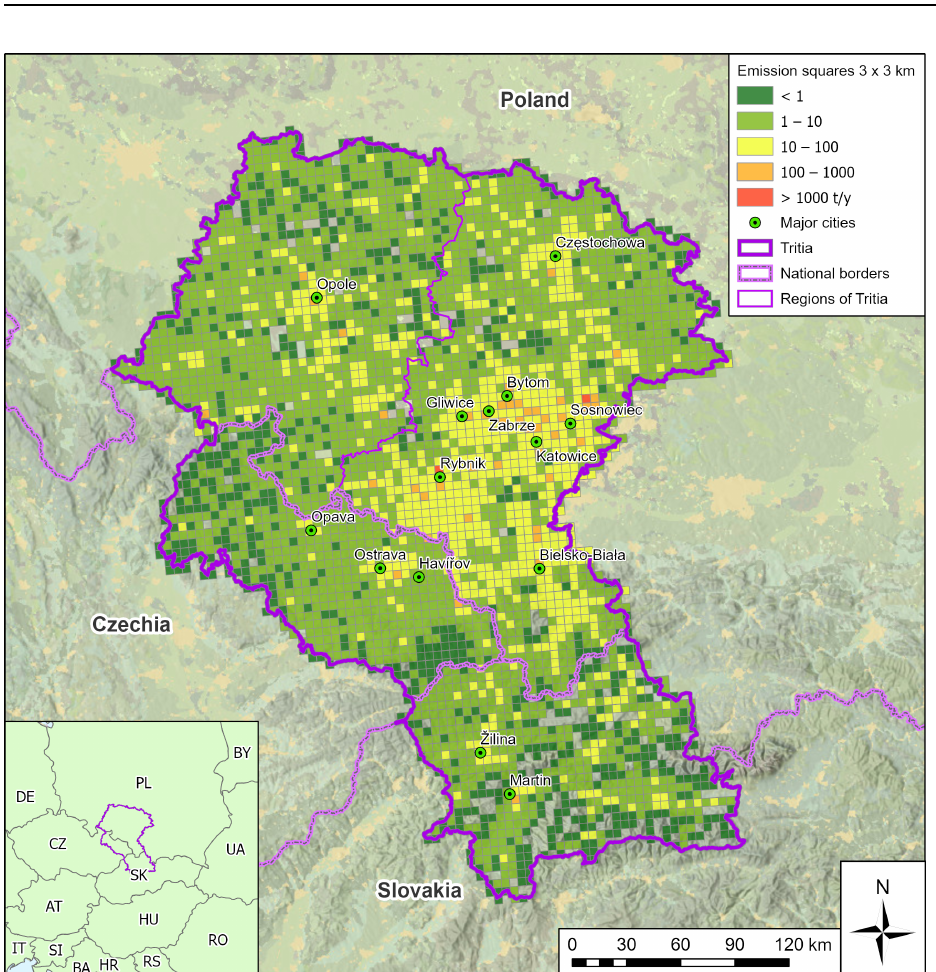
Figure 2. PM 10 emission distribution in the Tritia region. The modeling data were corrected by the pollution monitoring data. Two correction coefficients (additive + multiplicative) were added. The additive coefficient represents